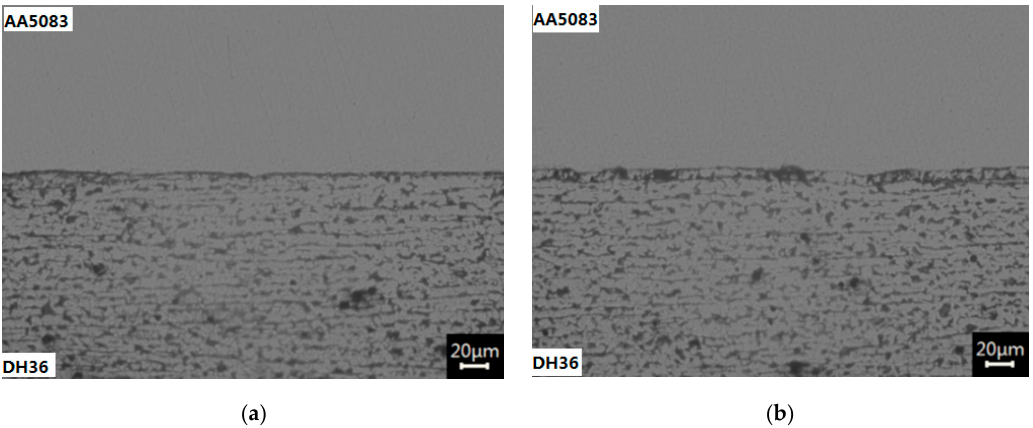
Figure 12. Deposition microstructures for specimen No. 3: ( a ) middle ( b ) retreating side.